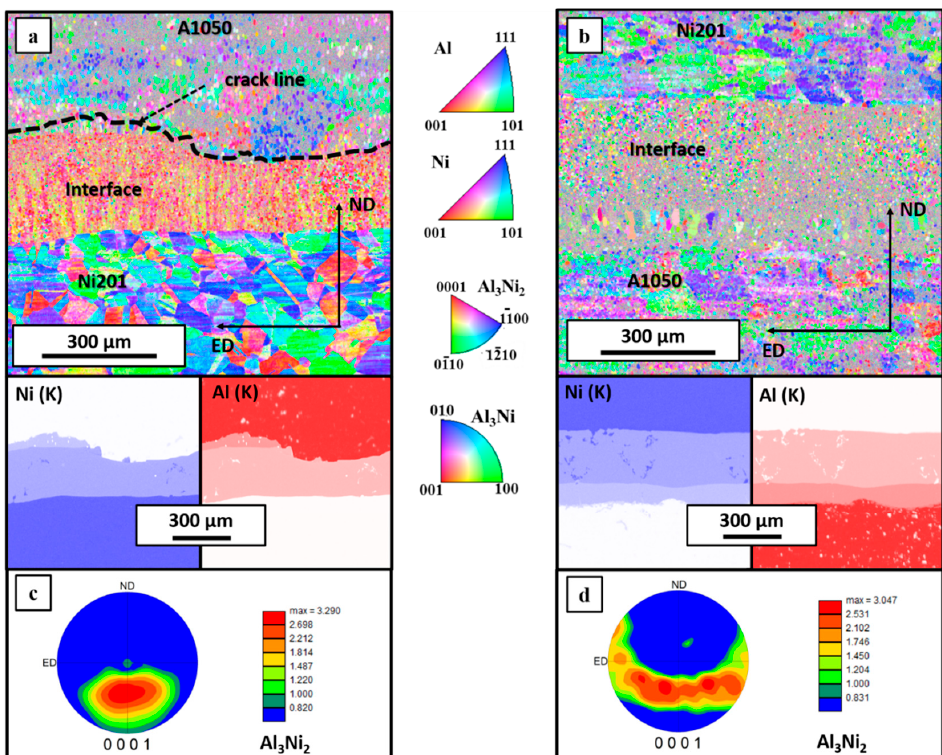
Figure 13. EBSD maps and EDS elemental distribution maps of Al(K) and Ni(K) corresponding to the interface zone after annealing at 500 ° C for 168 h in E2000 ( a ) and E 2800 ( b ) explosively welded clads with pole figure generated for Al 3 Ni 2 phase presented in ( c ) and ( d ), respectively.